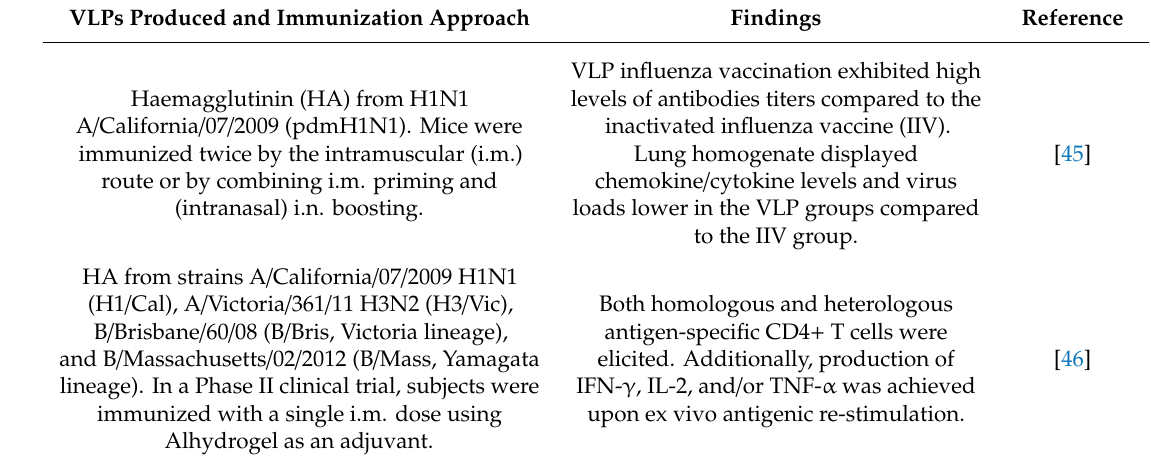
Table 2. Vaccines against influenza based on plant-made Virus-Like Particles (VLPs), evaluated in vitro or in mice and